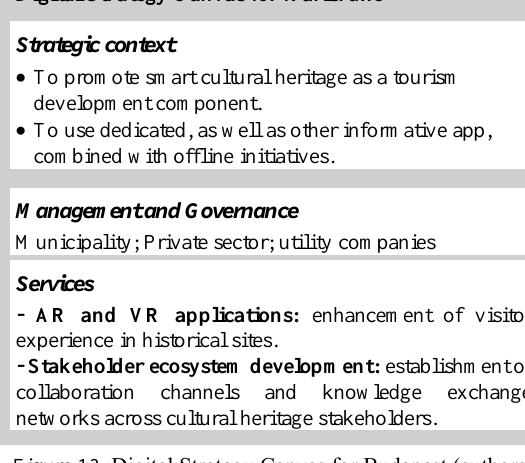
Figure 13. Digital Strategy Canvas for Budapest (authors’ elaboration).